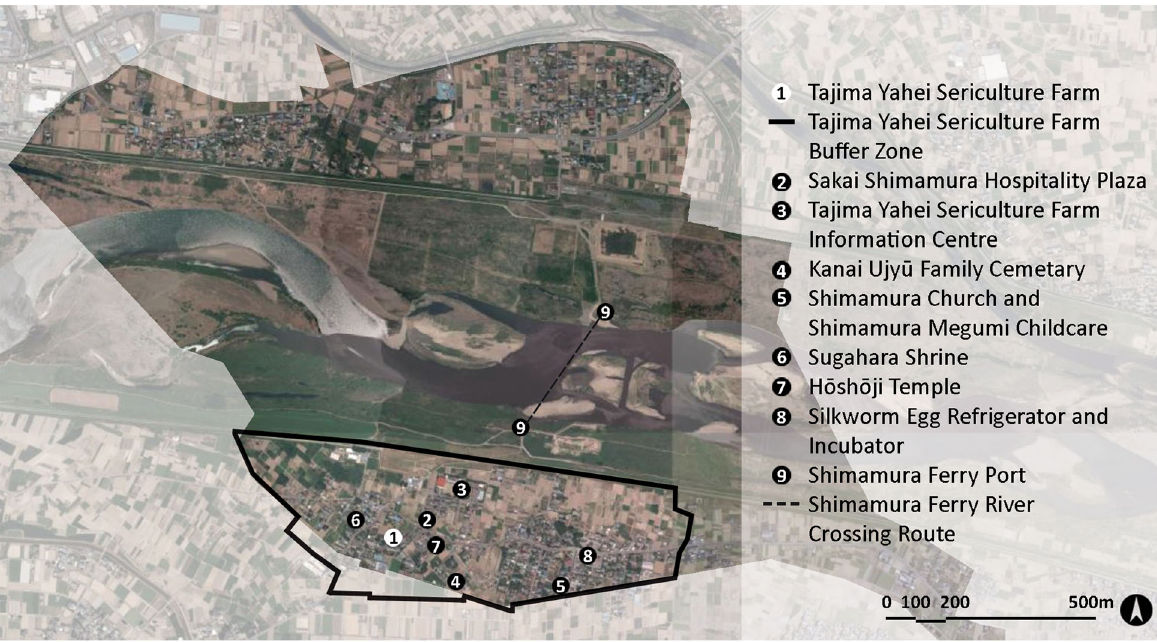
Fig. 6 Map of Shimamura, Tajima Yahei Sericulture Farm buffer zone and attraction points of Shimamura. (Source: Sweet Yee